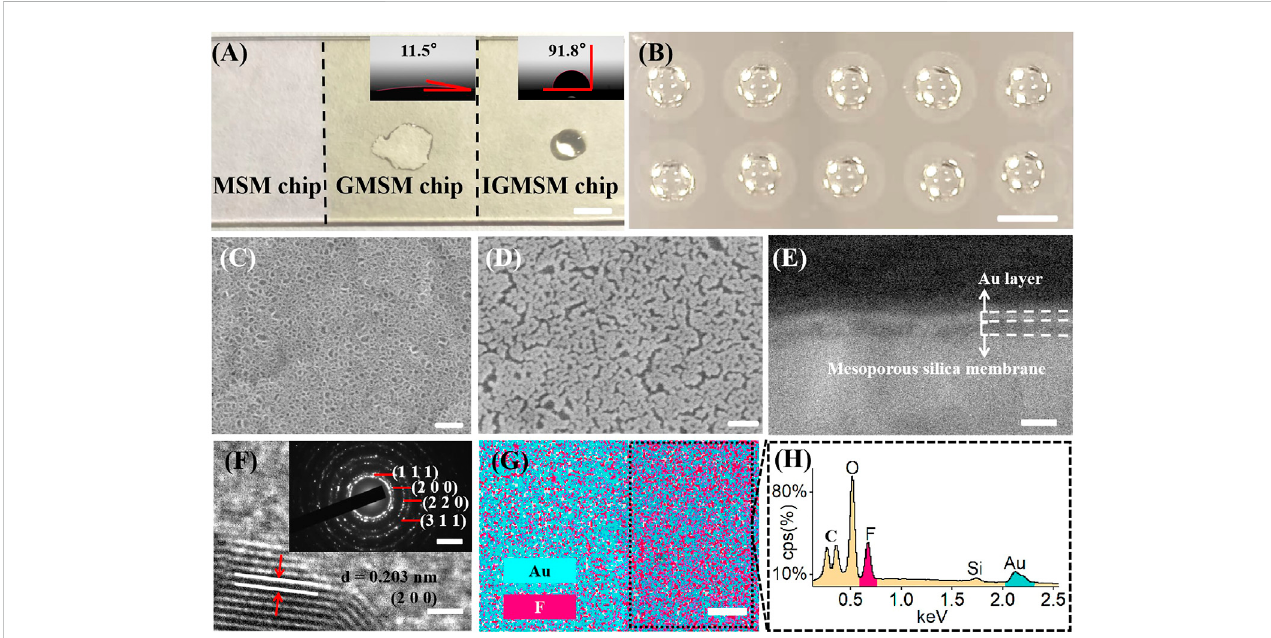
FIGURE 1 Construction of IGMSM chips: (A) Digital image and contact angle (inset) of IGMSM chips (scale bar is 5 mm). (B) Digital image of microarray printed chip (scale bar is 1 cm). Top-view image of SEM of (C) mesoporous silica membranes on ITO slide and (D) gold islands and mesoporous silica membranes on ITO slide (scale bar is 100 nm). (E) Cross-section image of SEM of IGMSM chip (scale bar is 100 nm). (F) HRTEM (scale bar is 1 nm) showing the gold crystal lattice and SAED pattern (inset) of gold islands (scale bar is 5 1/nm). (G) Corresponding element mapping images of the IGMSM chip (scale bar is 100 μ m). (H) EDS spectra of the area selected in the Figure